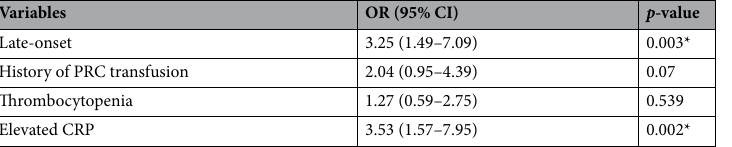
Table 3. Multivariate analysis of the clinical deterioration of premature neonates with NEC in our institution. *, p < 0.05; CI confidence interval, OR odds ratio, NEC necrotizing enterocolitis, PRC packed red cell, CRP C-reactive